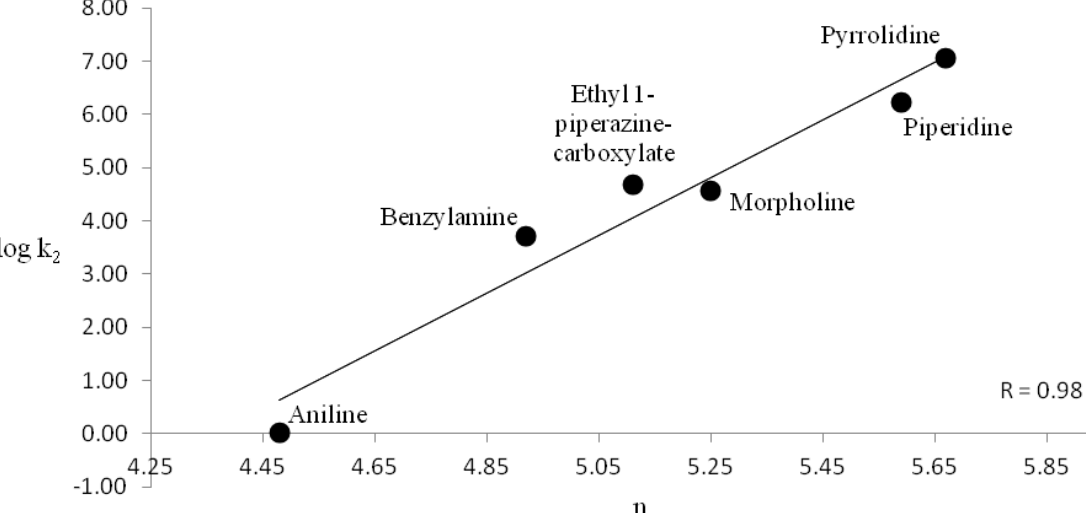
for benzoyl chloride–amine 2